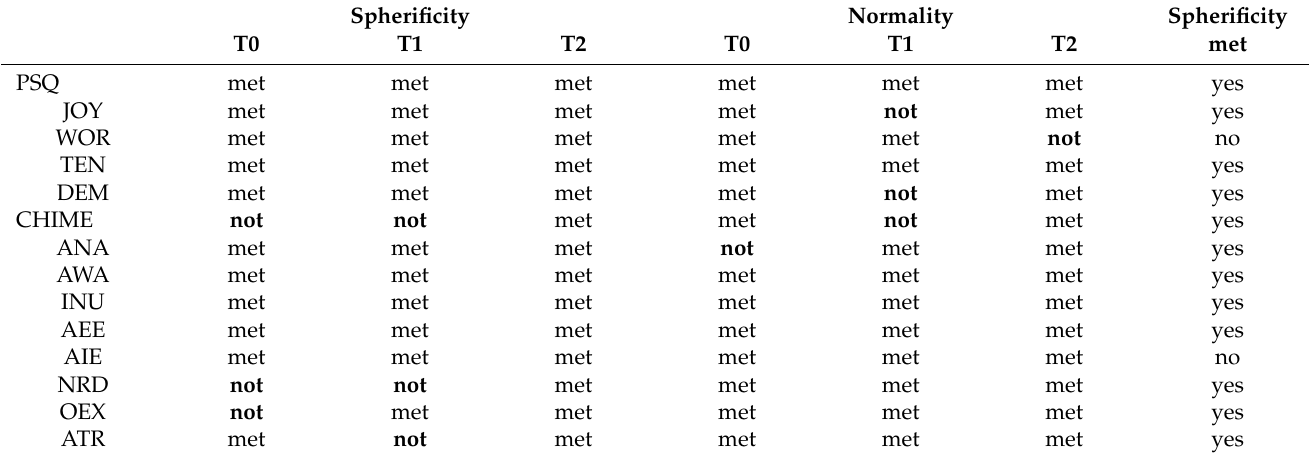
Table 6. Test results for requirements of two-way mixed ANOVA with repeated measures. Spherificity